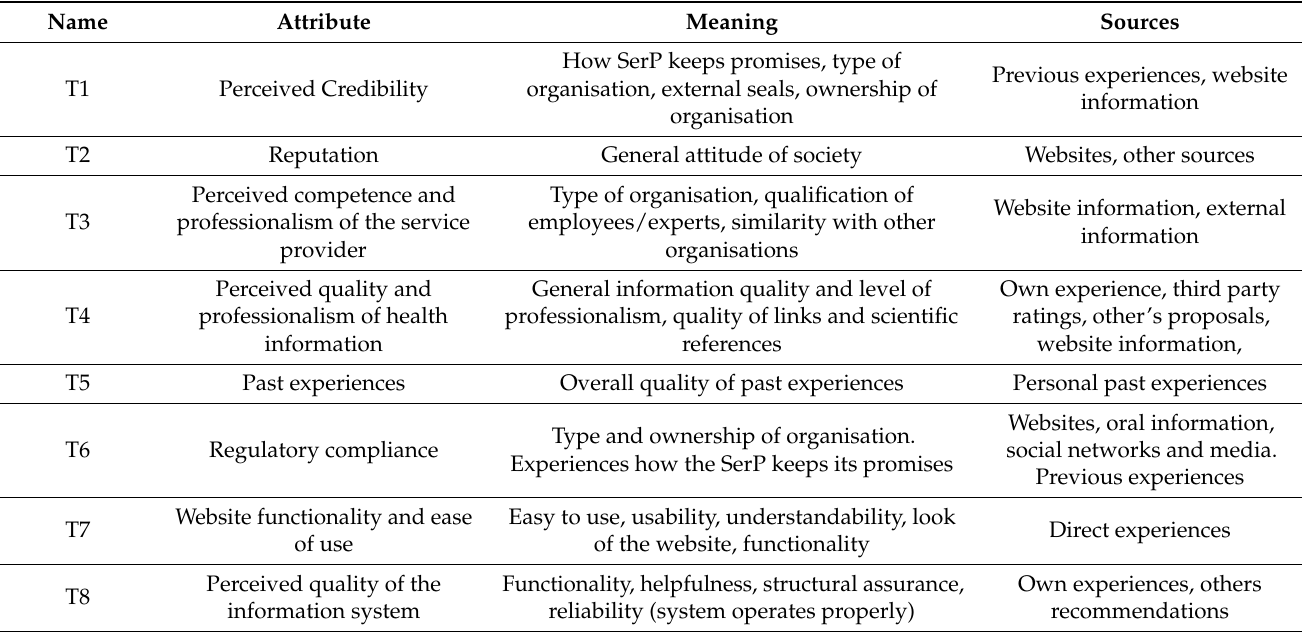
Table 4. Selected trust attributes for FAR